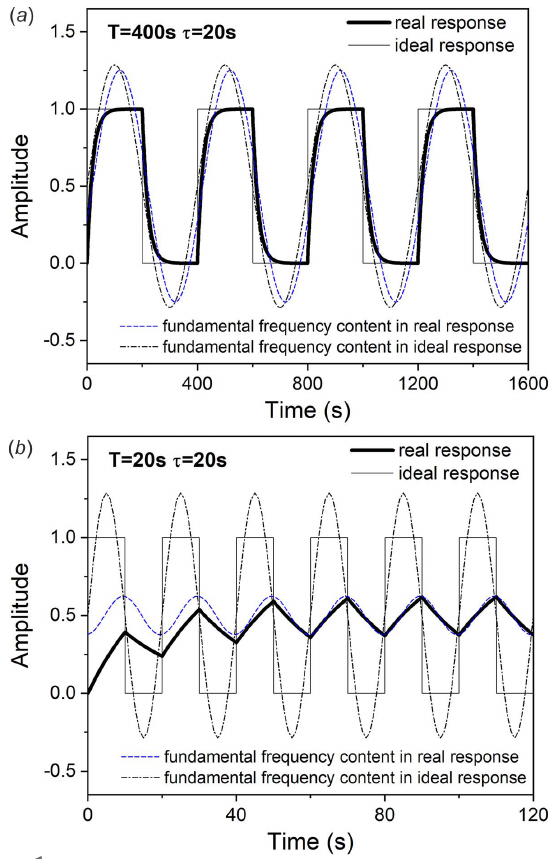
Figure 1 Time response of the first-order system with a square-wave input. The inputting waveform has a different period, 400 s in ( a ) and 20 s in ( b